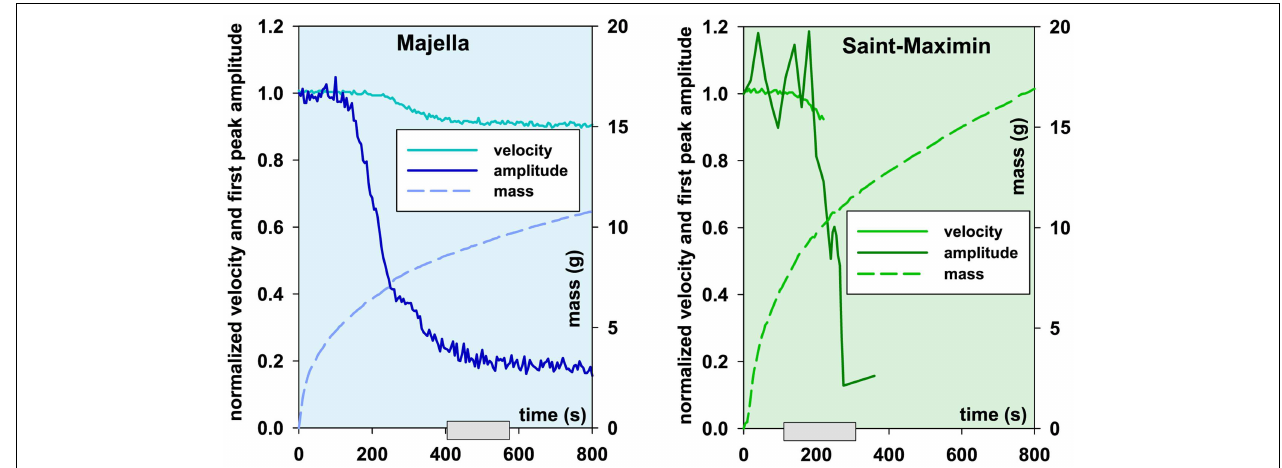
FIGURE 5 | Results from the imbibition experiments coupling ultrasonic measurements with the mass method for the Majella grainstone and the Saint-Maximin limestone: the velocity and first peak amplitude are normalized to their respective value in the dry